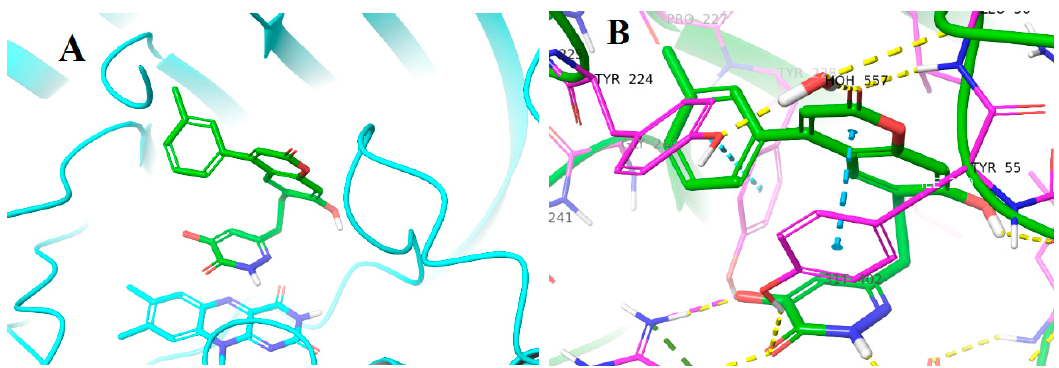
Figure 4. Proposed binding pose of compound 12 . ( A ) Overall structure with protein shown in ribbon diagram, ligand in green tube and the isoalloxazine ring of FAD in cyan tube representation. ( B ) Details of interactions are indicated by dashed lines: yellow hydrogen-bond, cyan aromatic–aromatic. (H-bond criterion: heavy atom distance < 2.8 Å; aromatic-aromatic contact criteria: face-to-face distance < 4.4 Å; face-to edge distance < 5.5 Å). * Standard deviations are shown in parenthesis. Table 1. Enzyme assay test results of compounds 8 – 13 .